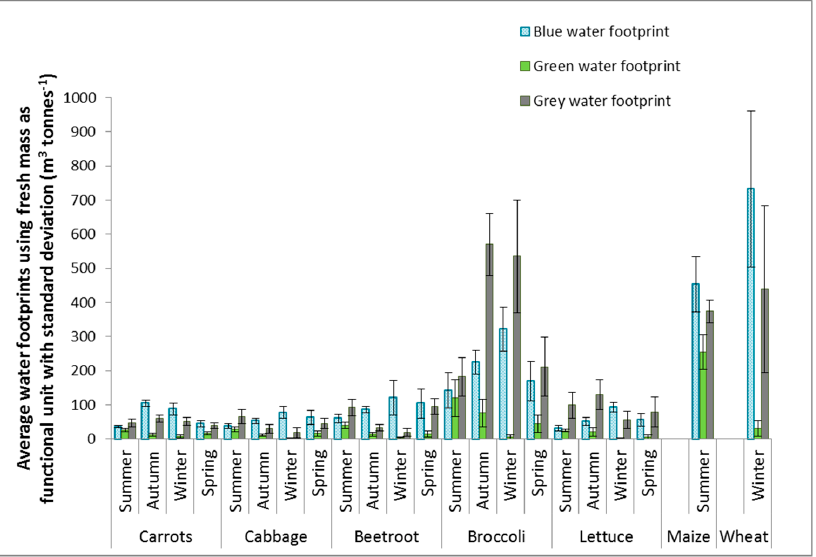
Figure 6. Average of 10 years’ blue and green water footprints (2004–2013) with standard deviations (shown as error bars) of vegetable and grain crops in the different growing seasons on the Steenkoppies Aquifer using fresh mass as a functional unit.